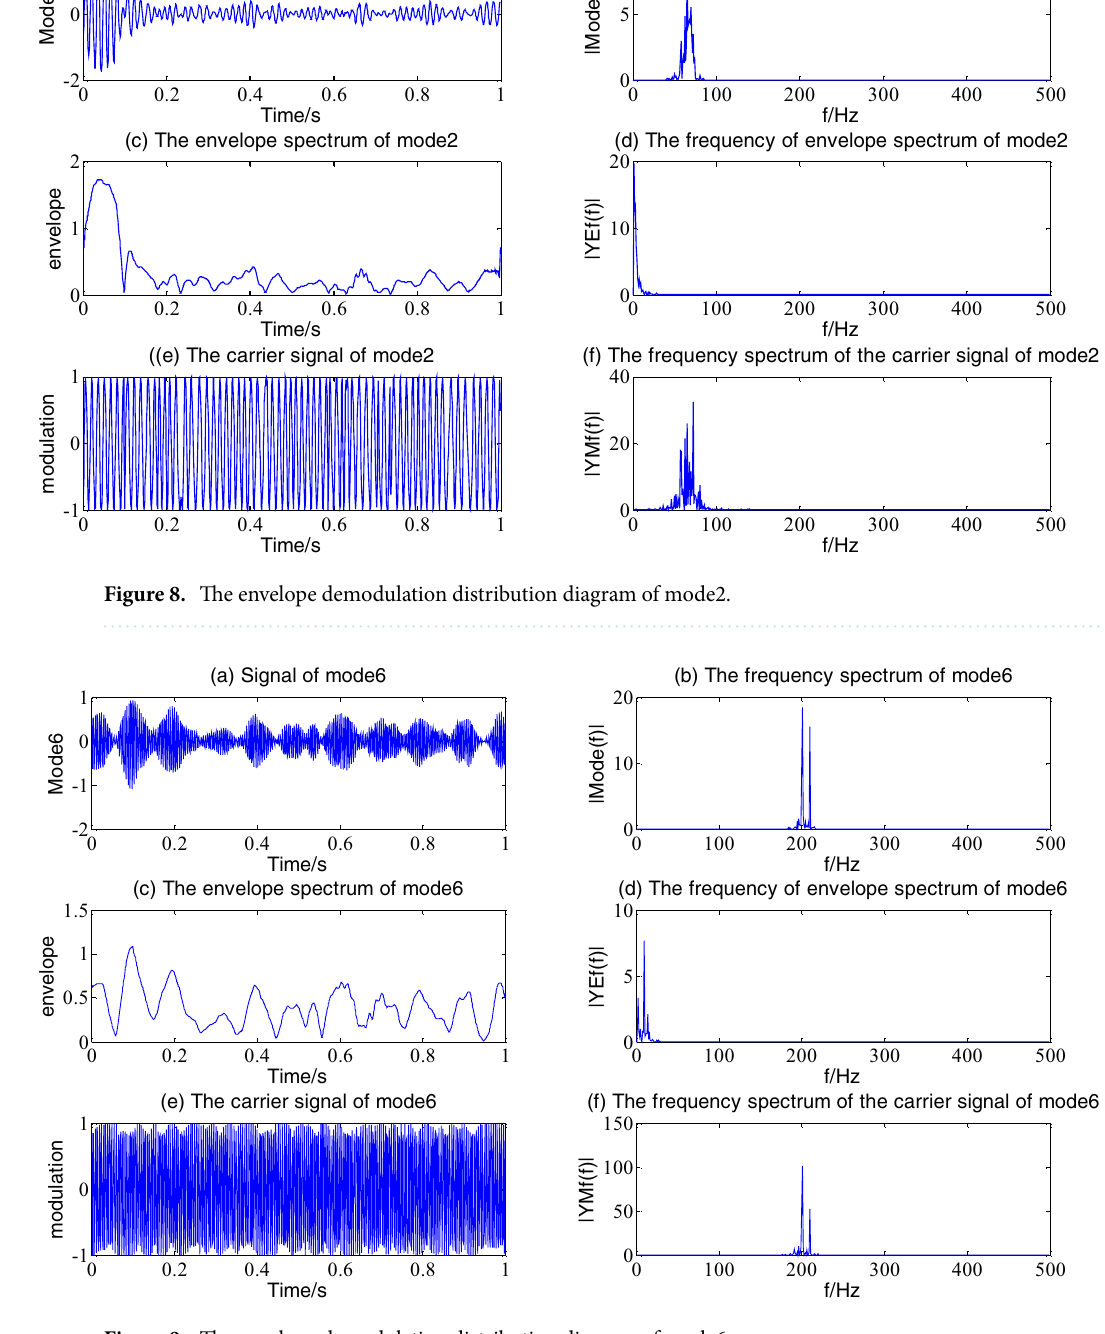
Figure 9. The envelope demodulation distribution diagram of